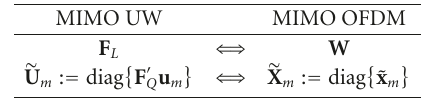
Algorithm 1. Note that typical values of the tolerances (cid:2) o and (cid:2) i , which are shown in Algorithm 1, are in the region